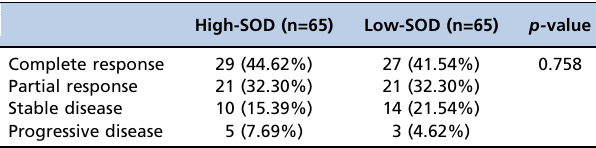
Table 3 - Tumor response rates in the high- and low-superoxide dismutase groups.